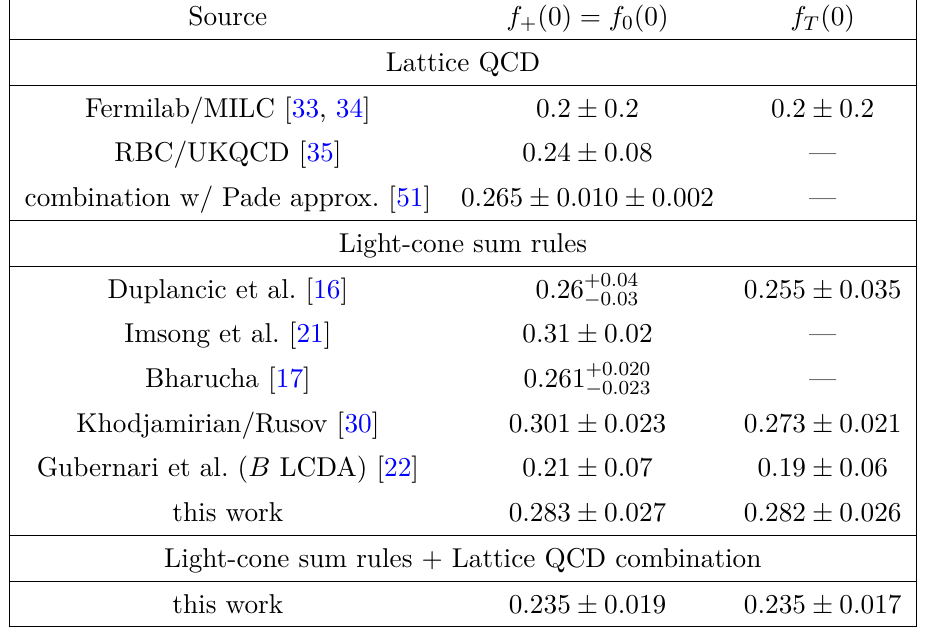
Table 6 . Comparison of our results for the form factor normalizations with other QCD-based results in the literature. The result of ref. [22] is included for completeness, although the authors caution that the threshold setting procedure employed in that work fails for the ¯ B → π form